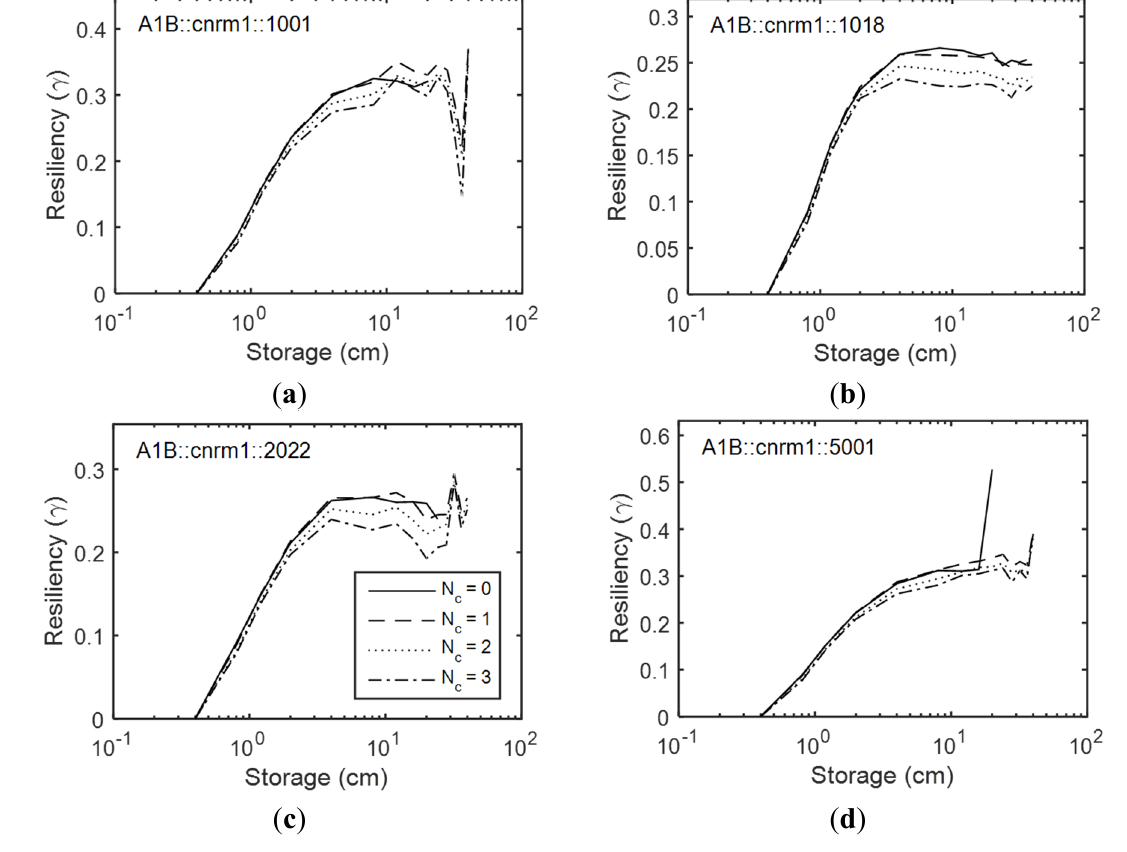
Figure 8. Resiliencies of four RBSNs under a projected climate change scenario (A1B,